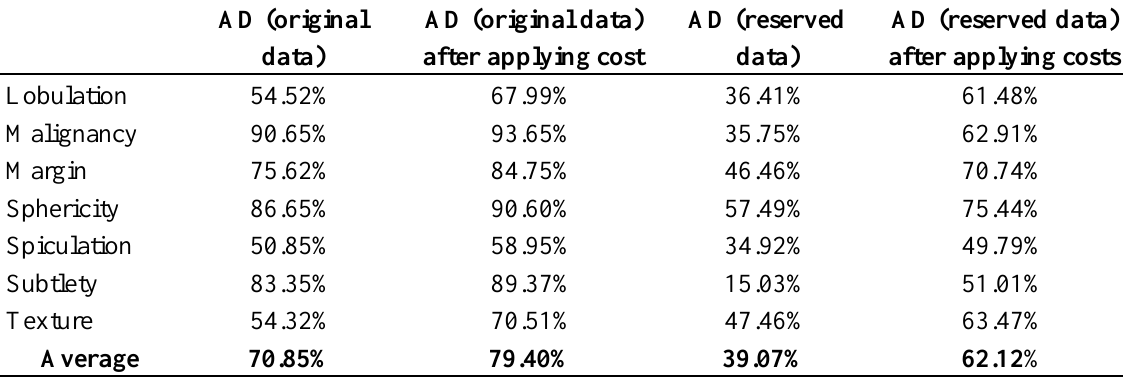
Table 9. Classification accuracies for original (90%) and reserved (10%) subsets after applying costs for degree of misclassification.